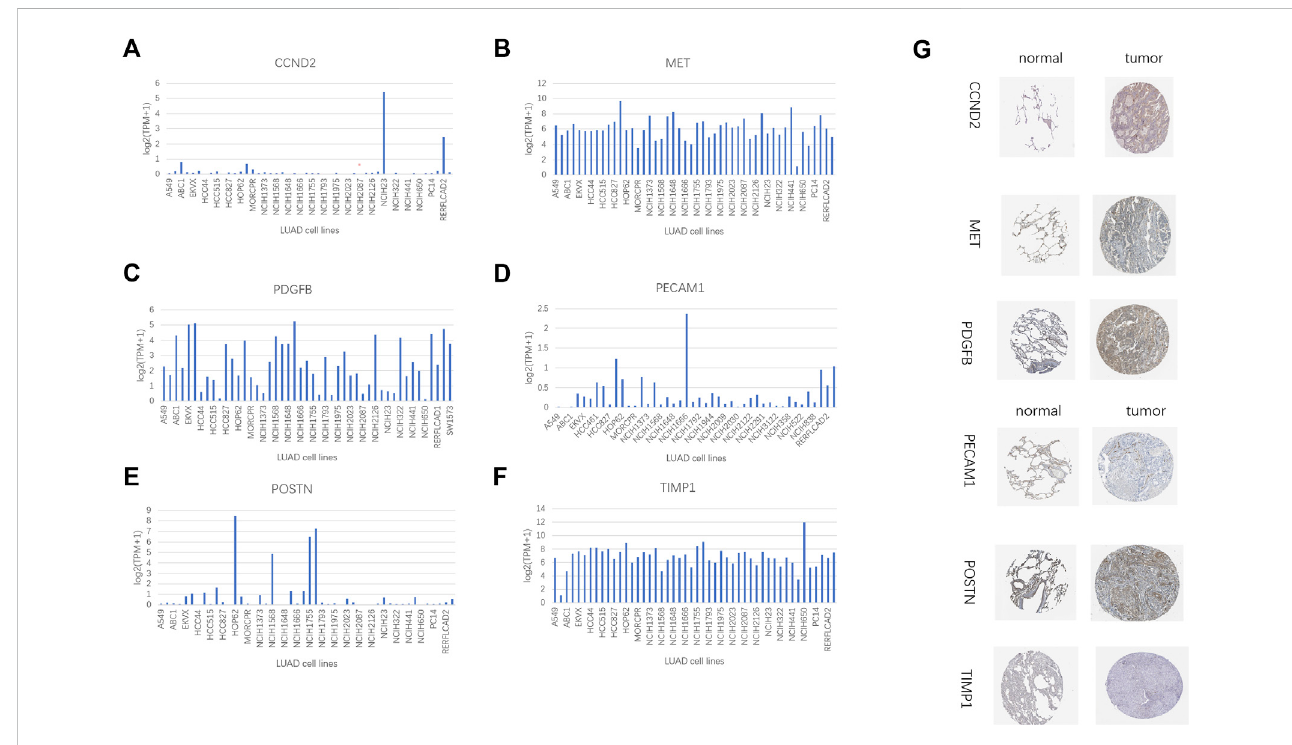
FIGURE 13 HPA database and compare gene expression in LUAD cell lines. (A) CCND2. (B) MET. (C) PDGFB. (D) PECAM1. (E) POSTN. (F) TIMP1. (G) Immunohistochemical results of 6 model genes in the HPA